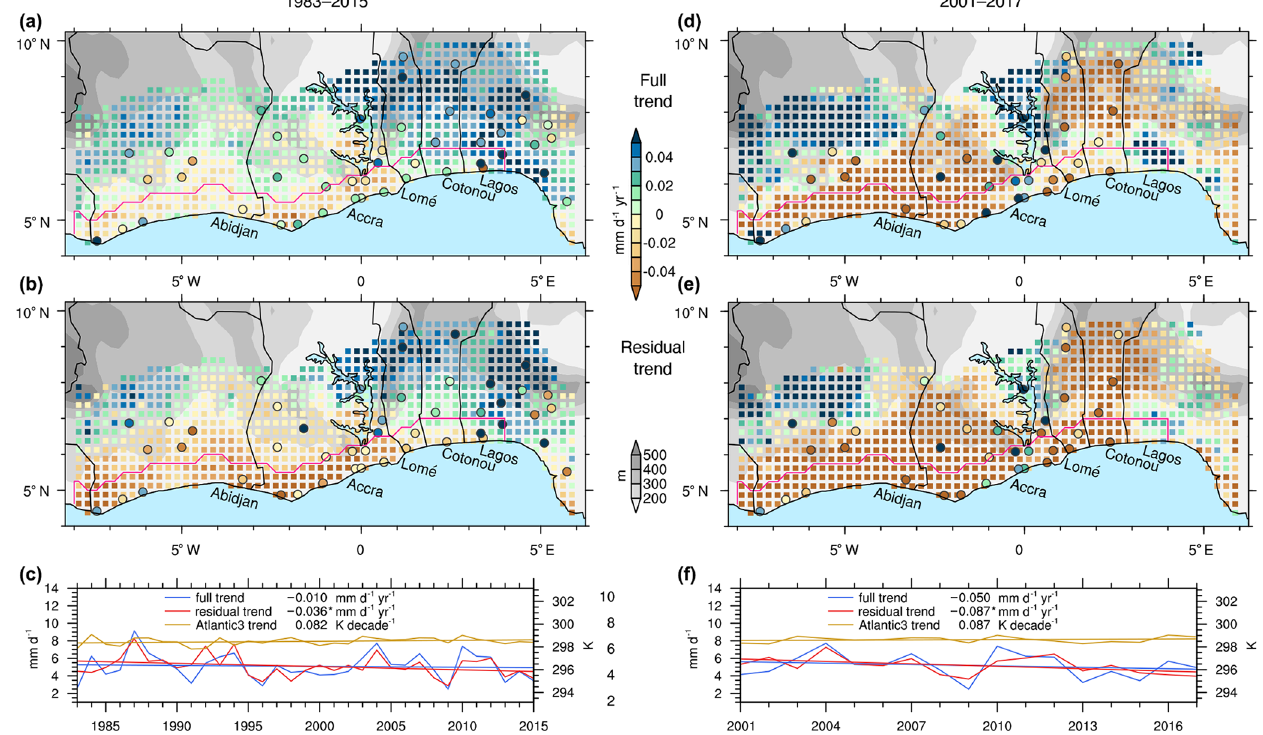
Figure 6. Rainfall trends during the second rainy season. (a–c) Trends in rainfall from 1983–2015 for CHIRPS data (coloured pixels) and station data (coloured circles). Panels (d) , (e) , and (f) are the same as (a) , (b) , and (c) but for recent trends from 2001–2017. Shown are full (a, d) and residual (b, e) trends. Note the overall good agreement between CHIRPS and station data. Topography is shown in grey shadings, and the coastal strip is marked by a pink line. “Residual” in this context means that a statistical model was used to remove the influence of other known climatic factors on rainfall (for details, see Sect. 2.4). Time series (c, f) of full (blue) and residual (red) CHIRPS rainfall, spatially averaged over the entire region, and the Atlantic 3 climate index (gold) are shown together with their trends over the respective time span. A * in (c) and (f) marks statistically significant trends on the α = 20%